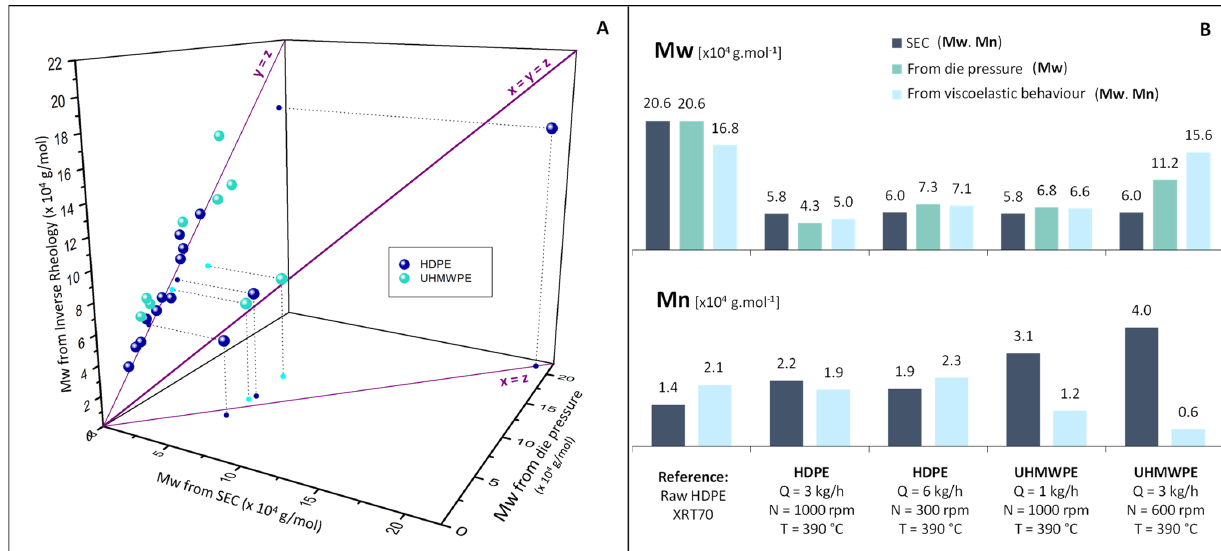
Figure 7. ( A ) Comparison of weight average molecular weight (Mw) of degraded polyethylenes obtained from the estimated zero shear rate viscosity versus the one obtained from viscoelastic behaviour measurements. ( B ) Comparison of weight average (Mw) and number average (Mn) molecular weight values obtained with different specified methodologies.